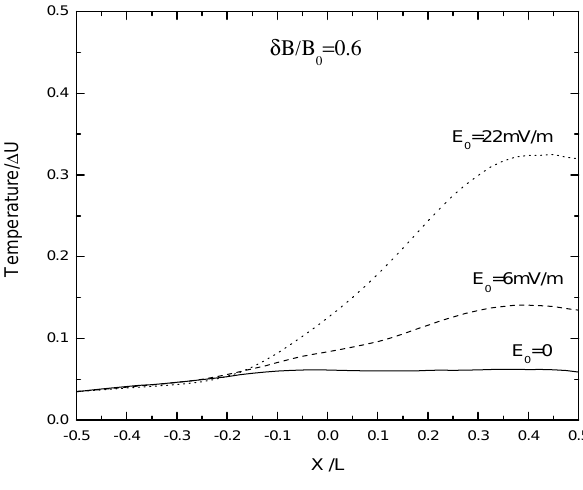
Fig. 12. Oxygen temperature profiles for different values of the electric field. Dimensionless